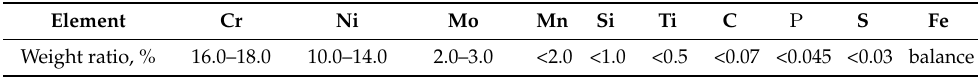
Table 2. Chemical composition of Cr18–Ni10–Ti stainless-steel sheet. Element Cr